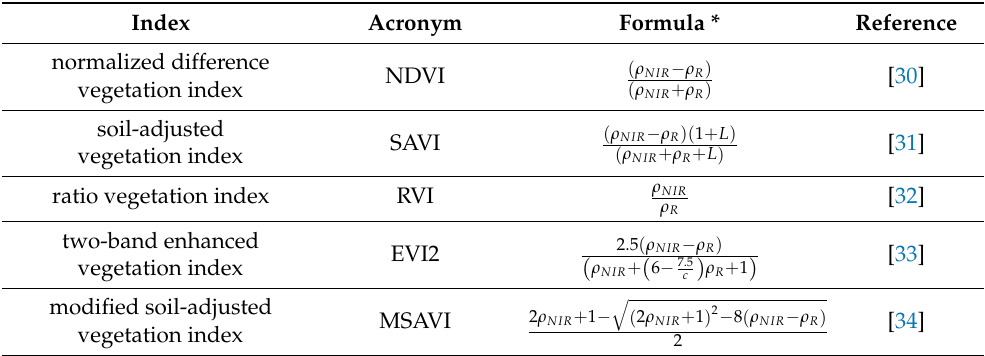
Table 2. Calculation methods of different vegetation